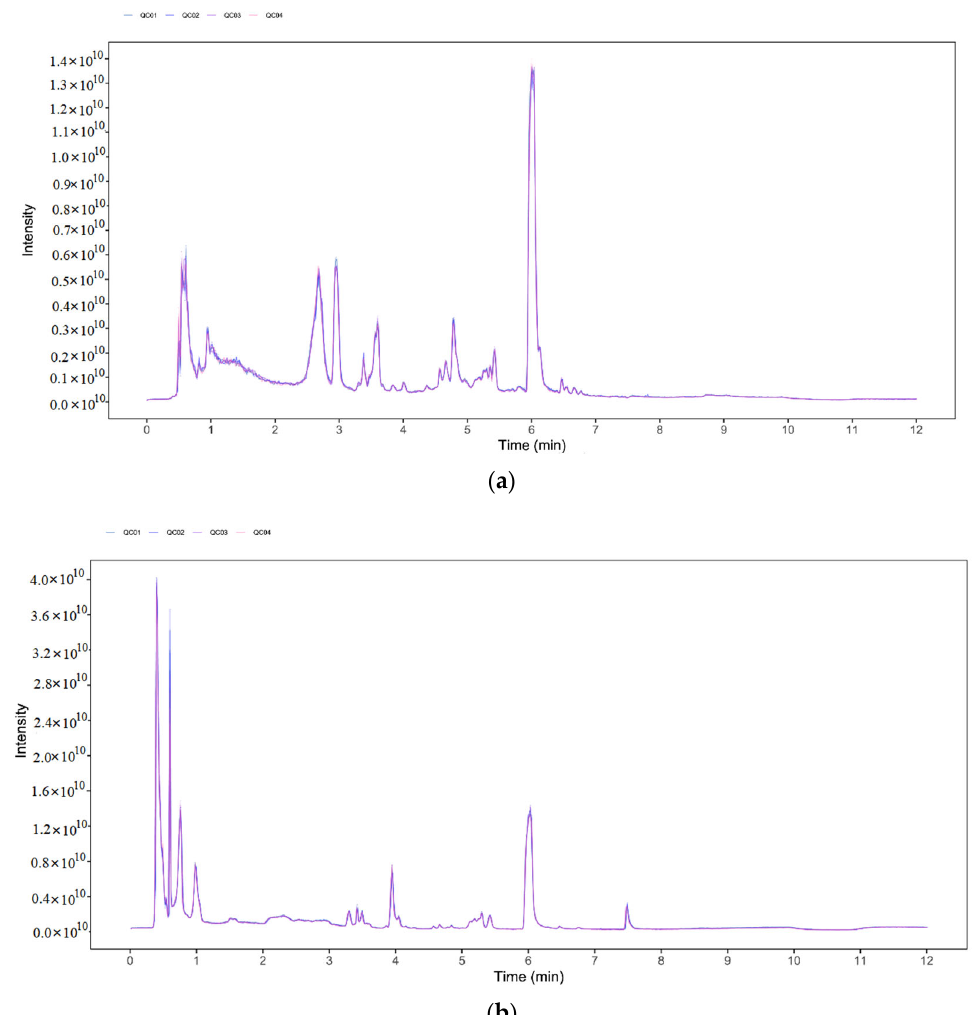
Figure 3. Total ion chromatograms (TICs) from all quality control (QC) samples detected by UHPLC ‐ QE ‐ MS in positive ( a ) and negative ( b ) modes. QC was prepared by mixing an equal aliquot of the supernatants from all samples. Q1 to Q4 were repeated samples to determine the stability of the instrument.